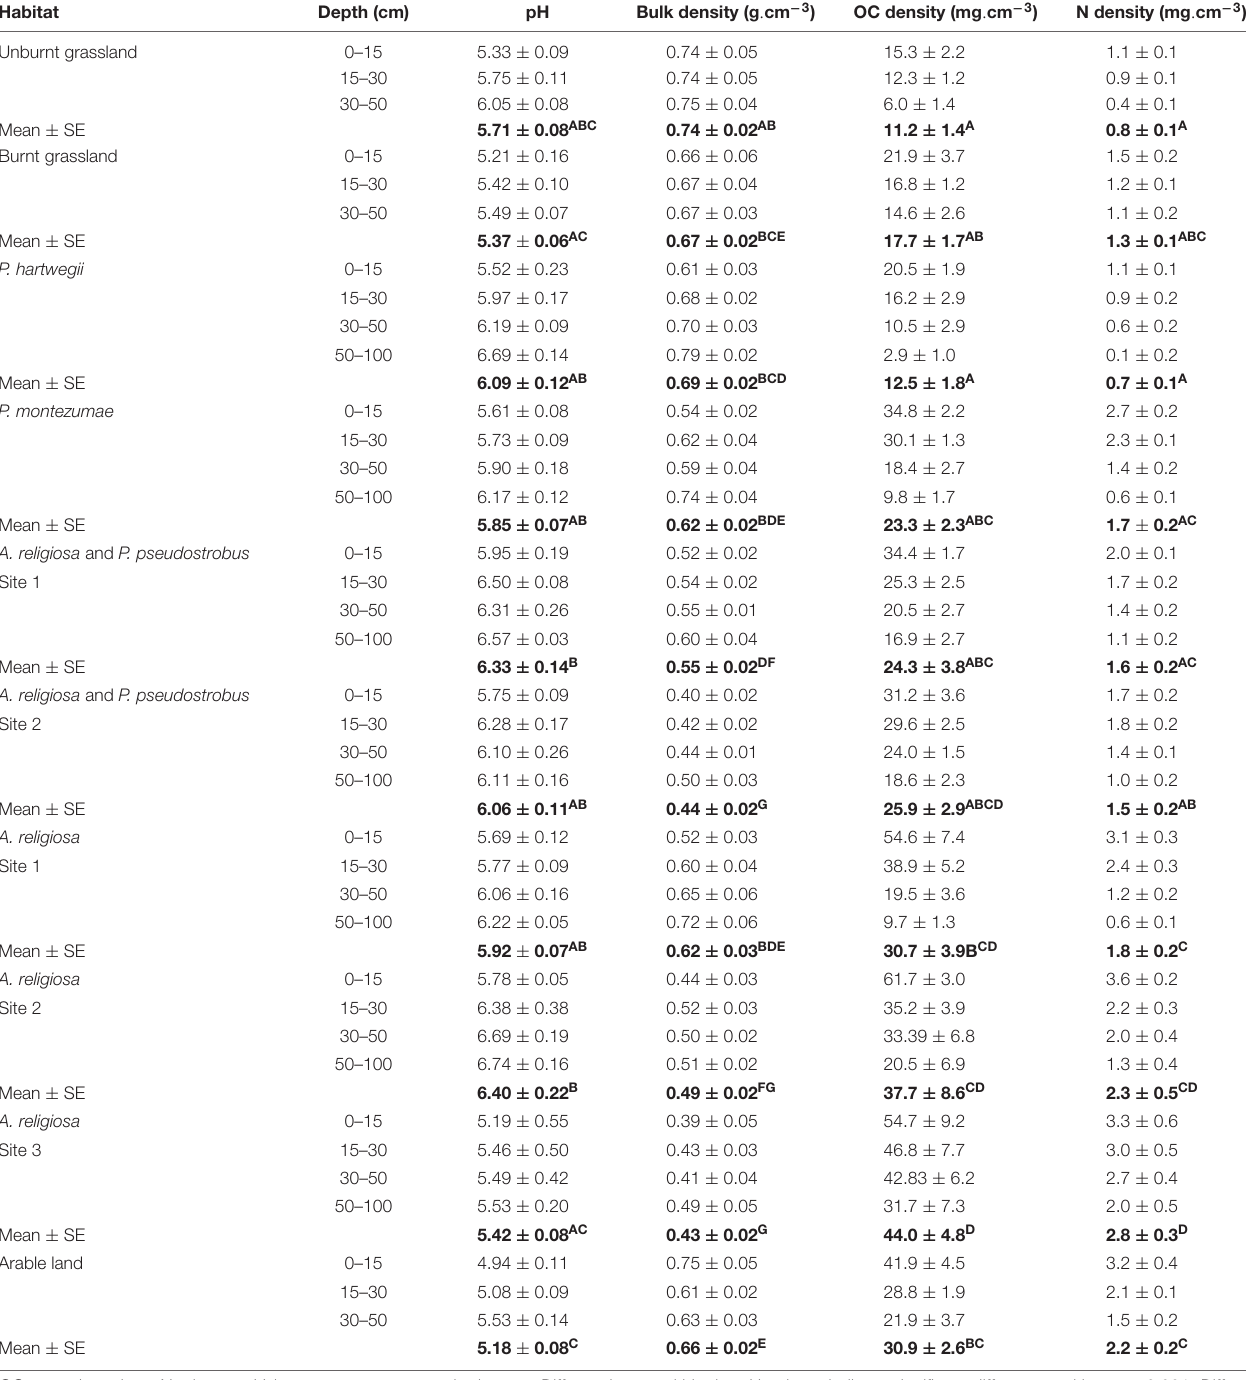
TABLE 4 | Physicochemical characteristics of soils at our studied habitats at Nevado de Toluca, State of Mexico, Mexico. Habitat Depth (cm) pH Bulk density (g . cm − 3 ) OC density (mg . cm − 3 ) N density (mg . cm − 3 ) Unburnt